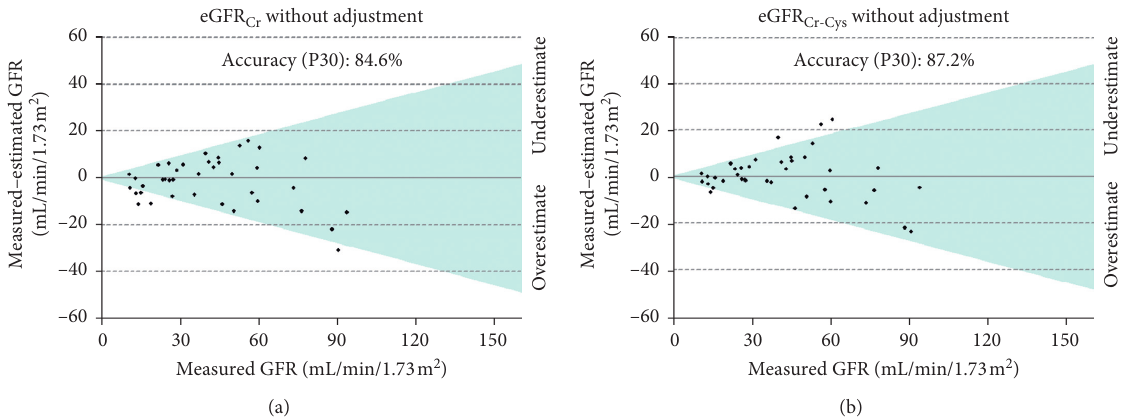
Figure 2: Accuracy of CKD-EPI equations for white participants ( n � 39), where dots inside the colour area mean a difference between measured and estimated GFR lower than 30% (P30).